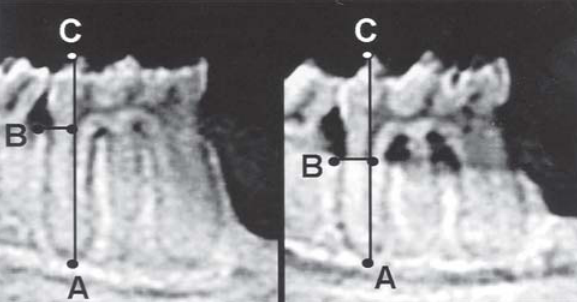
FIGURE1- Periodontal bone support (PBS) on the distal side of unligated (right) and ligated (left) teeth. AB indicates the distance from apex (A) to deepest bony defect (intersection of two lines), measured in mm. AC indicates the distance from apex (A) to cusp tip (C) measured in mm. PBS is calculated according to the formula: PBS=AB/ AC x